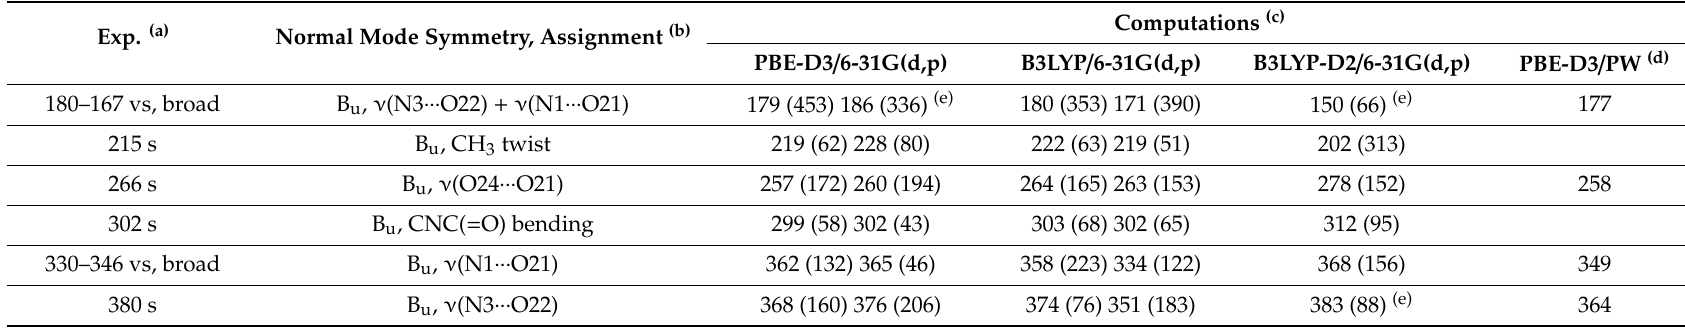
Table 2. Frequencies and infrared (IR) intensities of the low-frequency vibrations of [CRB + MLE] (1:1). Experiment vs. computations at di ff erent levels of approximation. The values obtained using the FullOpt option are shown in italics. The units are cm − 1 (wave numbers) and kM / mol